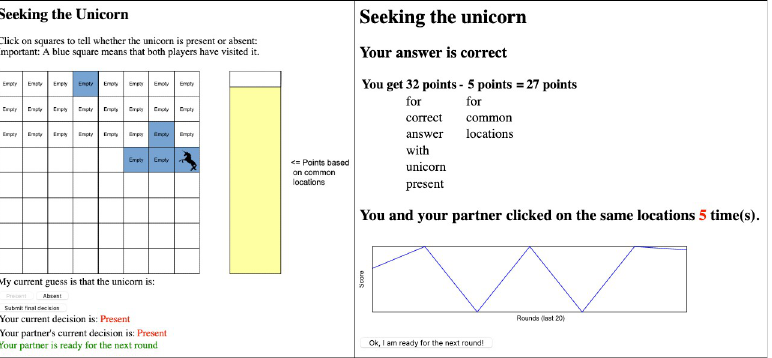
Fig 1. The experimental task. The left panel shows the grid as displayed to each player. By uncovering a tile, the player knows whether it is empty or contains the unicorn. Such information is private for the player. Tiles uncovered by both players have a blue background and both can immediately see this coloration. They also have access to each other’s guesses about whether the unicorn is present or absent. The yellow column on the right decreases as the number of overlapping tiles increases. The round ends when both players submit their final decision. In the right panel we show the screen displaying the score and the score history over the last 20 rounds.